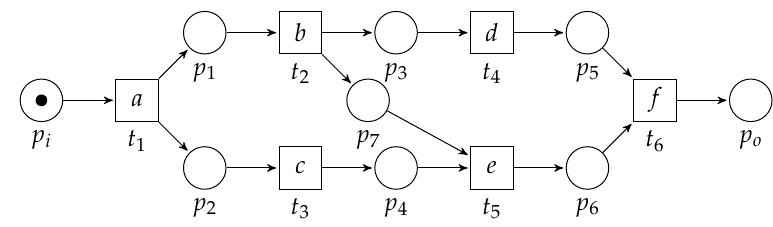
Figure 19. A Free-Choice WF-net for which the algorithm cannot find a corresponding process